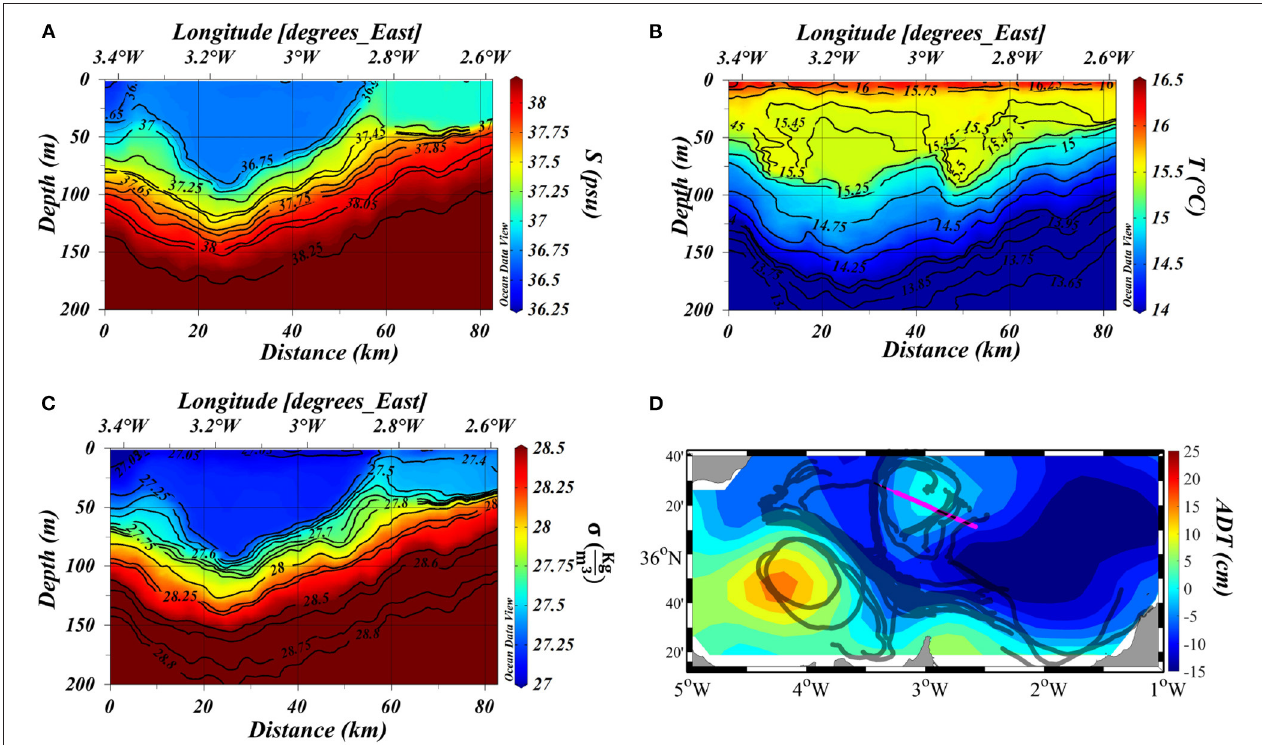
FIGURE 4 | UCTD transect (2–5 April) of salinity (A) , temperature (B) , and potential density (C) from the CALYPSO experiment 2019. Panel (D) shows the 4-day mean ADT, together with the position of the transect (in magenta, also shown in Figure 2 ), and drifter trajectories (CODE, CARTHE, and SVP) during the transect time